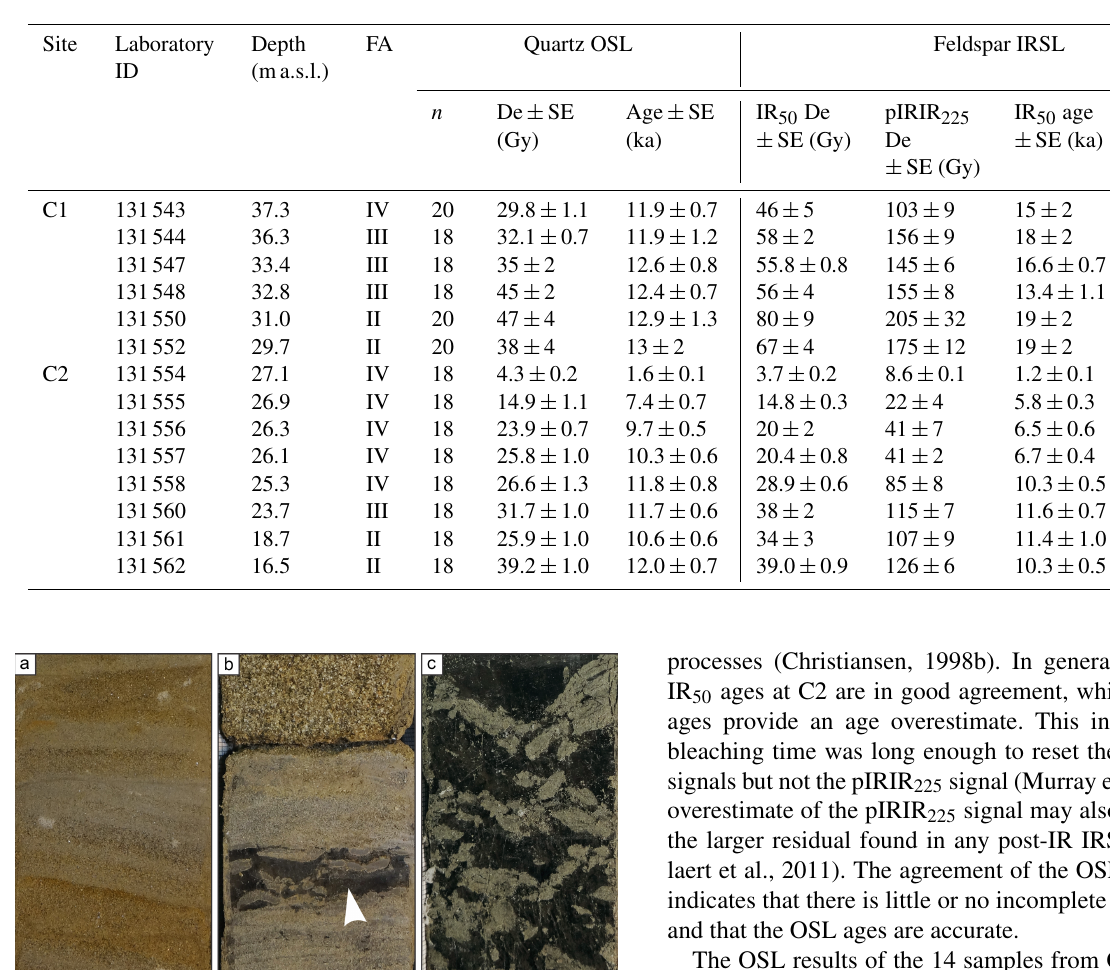
Table 2. Summary of core samples for luminescence dating, depths, quartz OSL, and feldspar IRSL equivalent doses (De) and ages. The feldspar doses and ages are based on the measurements of three aliquots per sample and are only used to check for incomplete signal resetting. The quartz ages are the basis for the chronologies of the sediment cores. n is the number of aliquots. SE is the standard error. IR 50 is the feldspar luminescence stimulated at 50 ◦ C by infrared light. pIRIR 225 is the feldspar luminescence stimulated at 225 ◦ C after stimulation at 50 ◦ C.